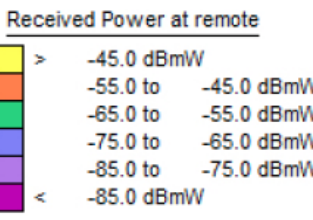
Figure 4. Colour range of received power at remote indoor.